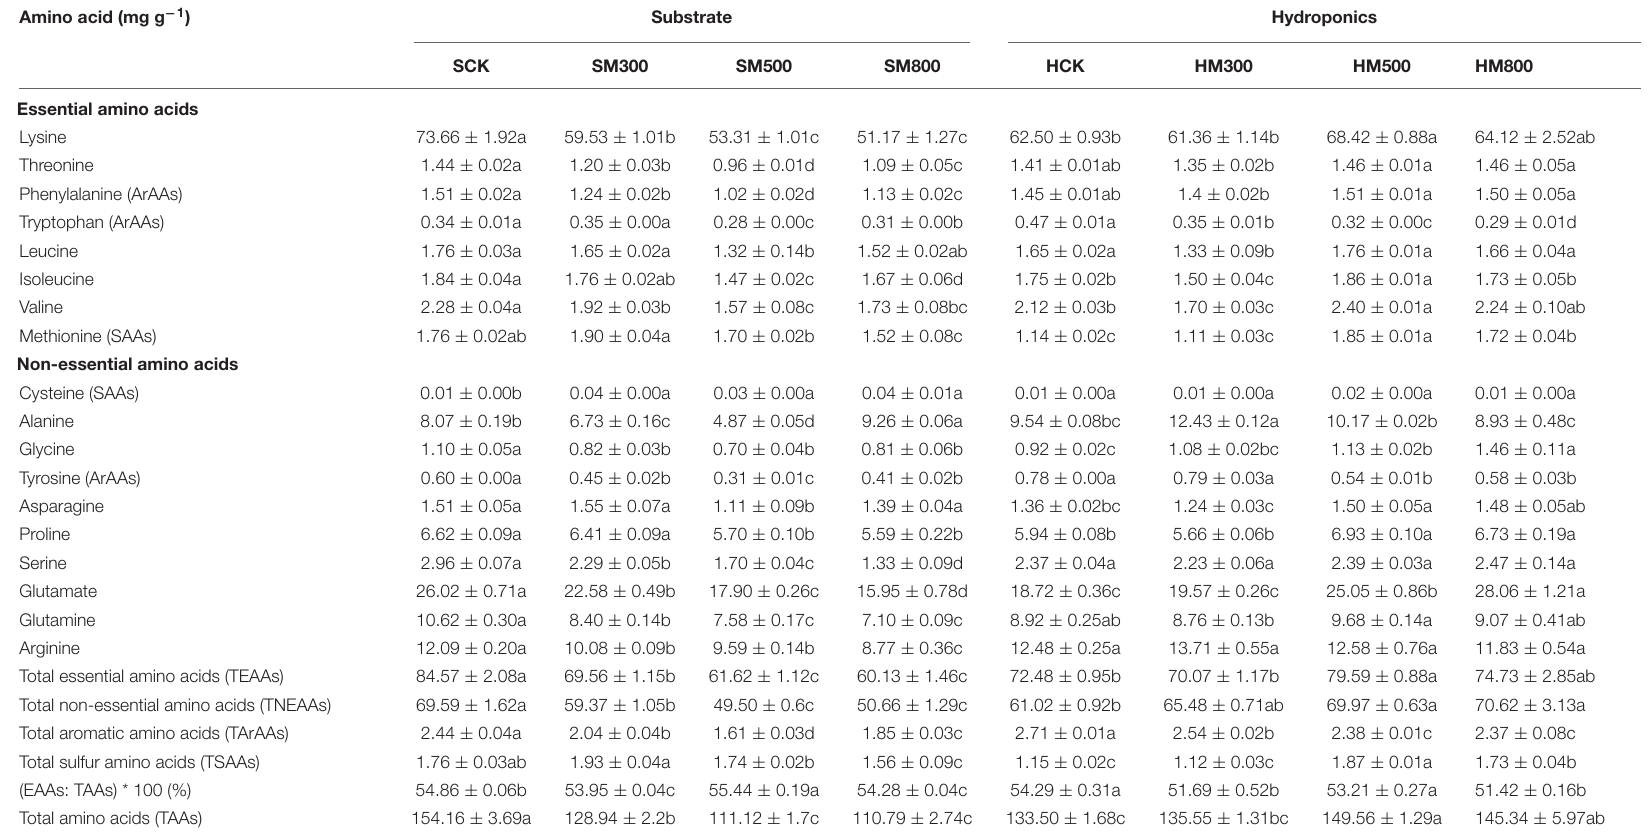
Data represent the mean ± standard error (n = 3). Different lowercase letters indicate statistical significance by Duncan’s multiple range test (p <